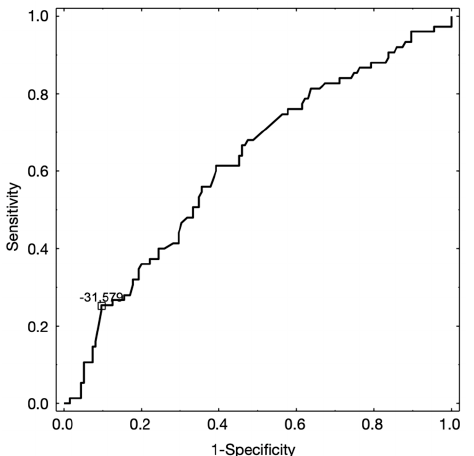
Figure 12. Diagram for receiver operating curve (ROC) analysis to assess the cut-o ff value of the parameter (P − A) / (P + A) between the groups with and without TMJ reciprocal clicking.